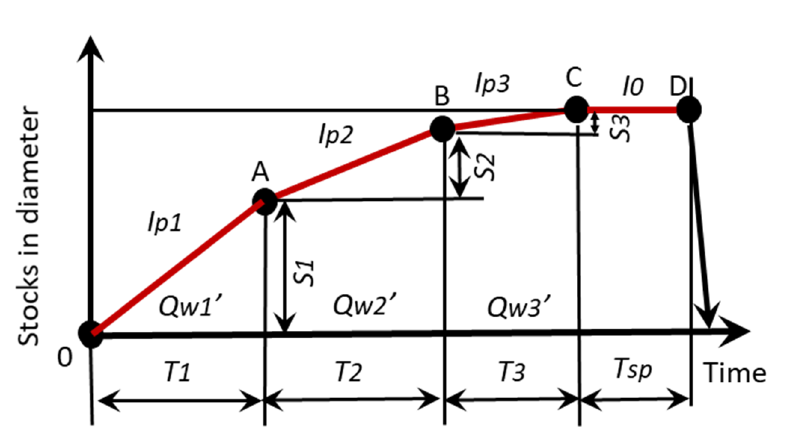
Figure 19. SMRR (Specific Material Removal Rate) and stock assignments.